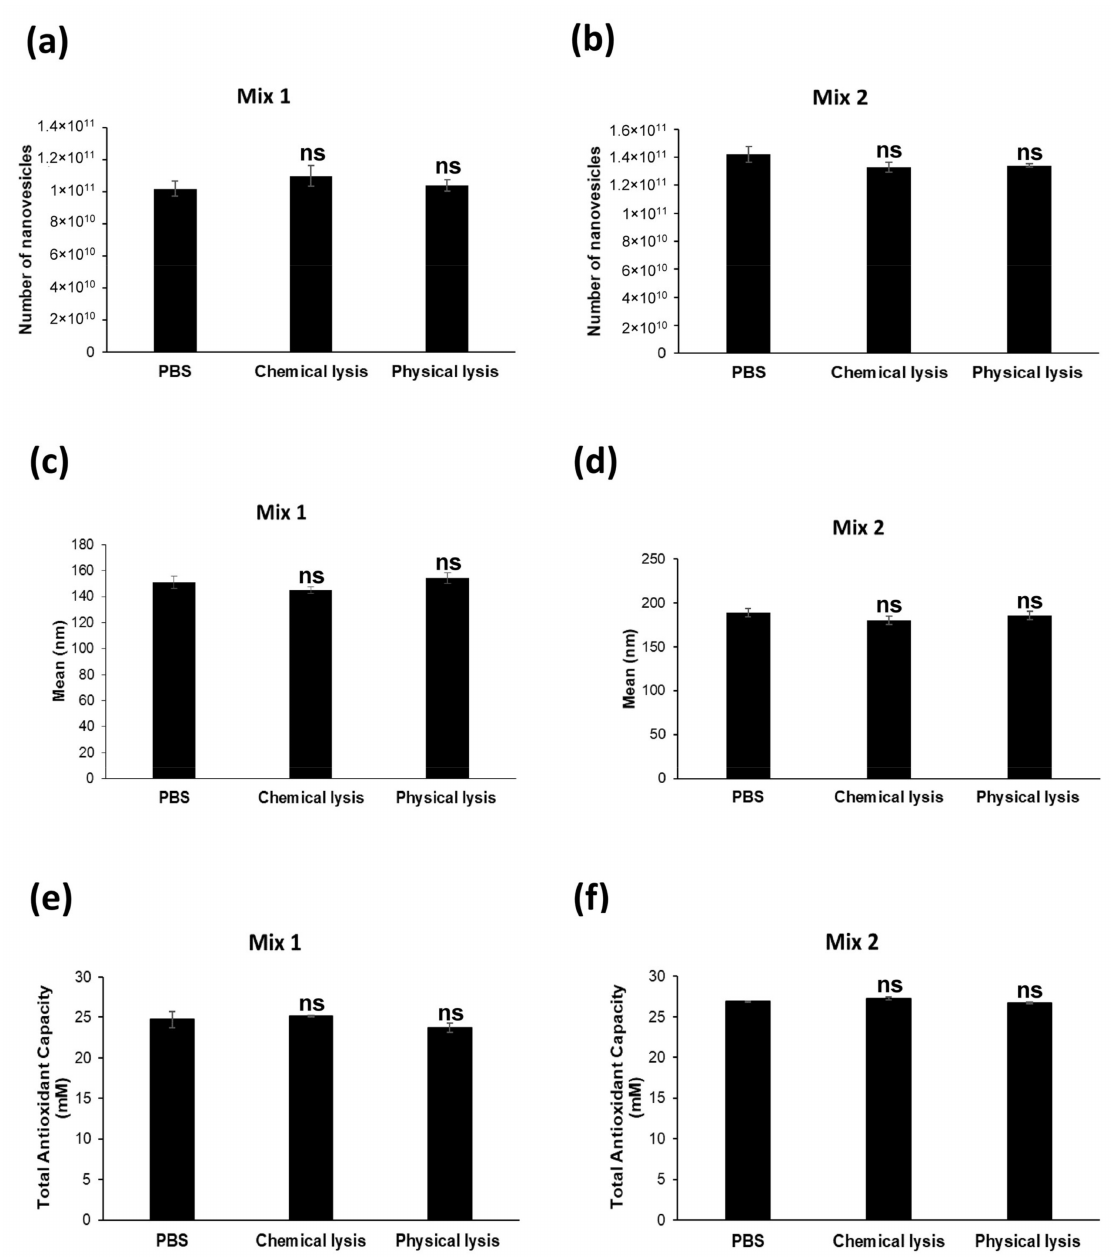
Figure 5. Evaluation of nanovesicle resistance to lysis: ( a ) comparison of the number of nanovesicles isolated from Mix 1 in PBS (not lysed), after chemical lysis (CHAPS buffer) and physical lysis (ultrasonic bath sonicator), analyzed through NTA; ( b ) comparison of the number of nanovesicles isolated from Mix 2 in PBS (not lysed), after chemical lysis (CHAPS buffer) and physical lysis (ultrasonic bath sonicator), analyzed through NTA; ( c ) comparison of the mean size of the nanovesicles isolated from Mix 1 in PBS (not lysed), after chemical lysis buffer (CHAPS buffer) and physical lysis (ultrasonic bath sonicator), analyzed through NTA; ( d ) comparison of the mean size of the nanovesicles isolated from Mix 2 in PBS (not lysed), after chemical lysis buffer (CHAPS buffer) and physical lysis (ultrasonic bath sonicator), analyzed through NTA; ( e ) comparison of the Total Antioxidant Capacity in nanovesicles isolated from Mix 1 in PBS (not lysed), after chemical lysis (CHAPS buffer) and physical lysis (ultrasonic bath sonicator), analyzed through a colorimetric ELISA kit; ( f ) comparison of the Total Antioxidant Capacity in nanovesicles isolated from Mix 2 in PBS (not lysed), after chemical lysis (CHAPS buffer) and physical lysis (ultrasonic bath sonicator), analyzed through a colorimetric ELISA kit. Data are expressed as the mean ± SE. ns: p >